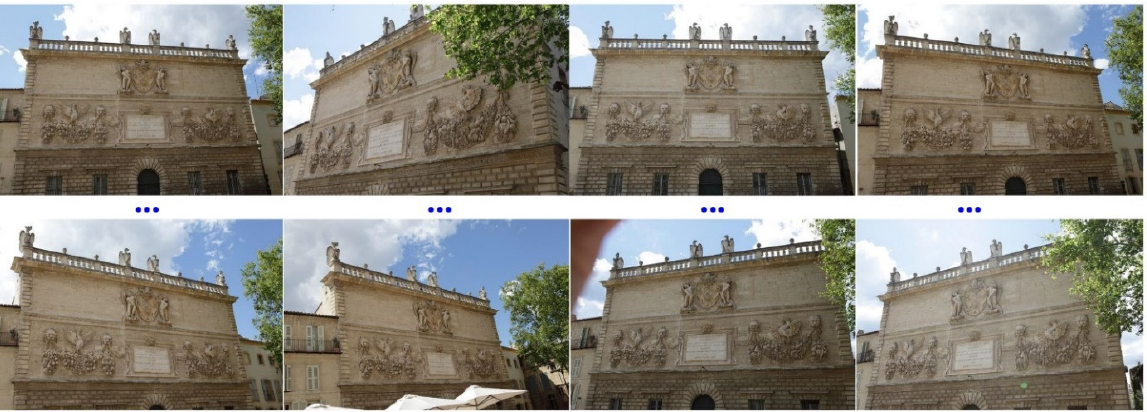
Figure 10. Samples of the Hotel sequence. Note that these figures have more repeated features and symmetrical